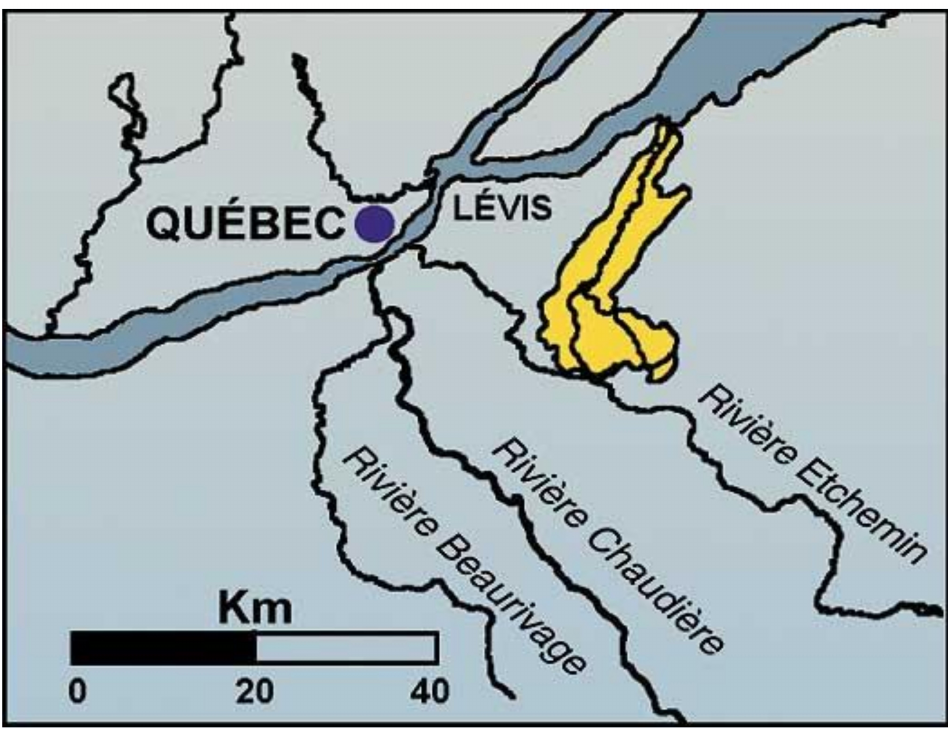
Figure 1. Location of the Boyer River watershed (46 ◦ 53 (cid:48) N, 70 ◦ 51 (cid:48) W), St. Lawrence Valley lowlands, Southern Quebec (Canada). From: https://www.environnement.gouv.qc.ca/milieu_agri/pratiques- agri/boyer/intro.htm (accessed on Fall